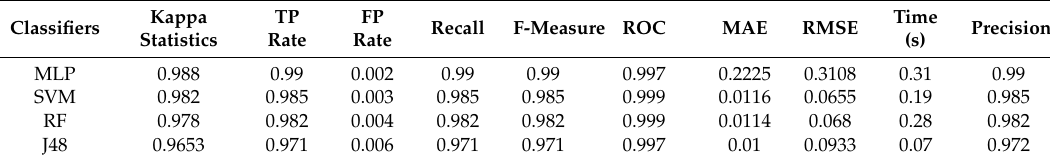
Table 5. The overall classification accuracy table of the employed ML classifiers on the fused